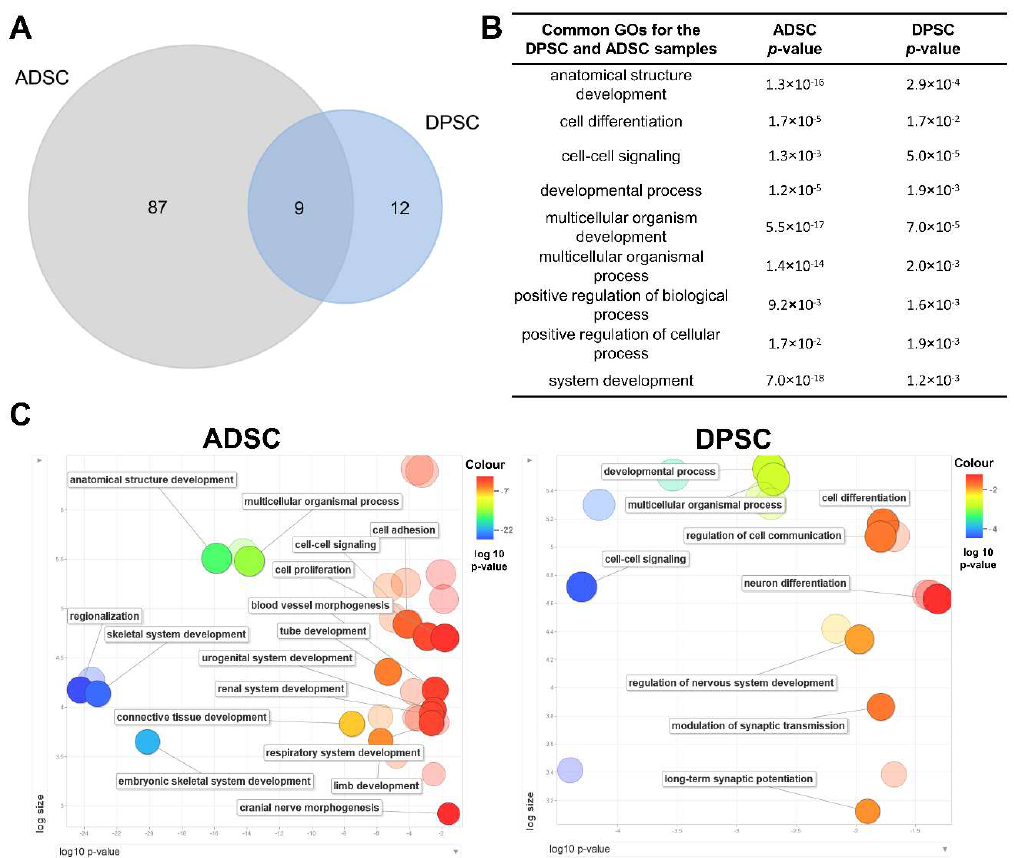
Figure 5. Functional enrichment analyses of DEGs in ADSCs and DPSCs. ( A ) Venn diagram of the GO terms for biological process terms identified in ADSCs and DPSCs samples. The diagram shows an overlap in GO terms that were common between the ADSCs and DPSCs. ( B ) GO terms that were common between the ADSCs and DPSCs with p -values. ( C ) GO enrichment analysis summarised and visualised as a scatter plot using REVIGO. Summarised exclusive set of GO terms related to biological process in the ADSCs and DPSCs. GO terms were ordered in relation to the p -value (x-axis) obtained from GO term enrichment analysis and the frequency of GO terms in the Gene Ontology Annotation Database (y-axis). Bubble colour indicates the provided p -value. DEGs: differentially expressed genes; ADSCs: adipose tissue-derived stromal cells; DPSCs: dental pulp-derived stromal cells; GO: Gene Ontology.